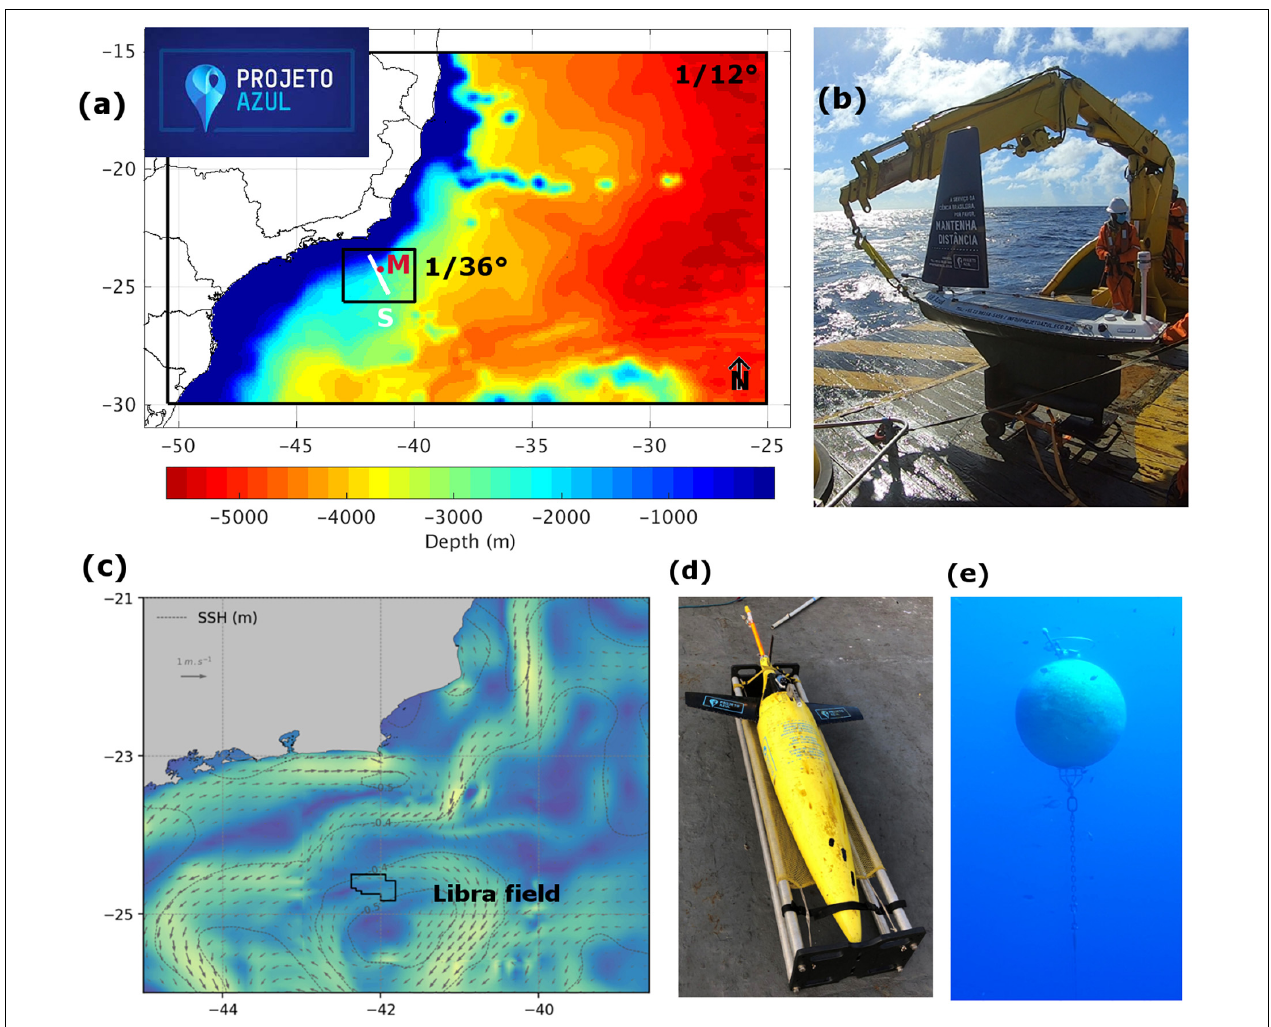
FIGURE 3 | (a) Representation of Project Azul’s nested grids (black rectangles) and their bathymetry (color shading), in meters, the approximated seaglider trajectories (S, white line) and the positioning of the instrumented mooring line and sail buoy deployment (M, red dot). (b) Sailbuoy deployment. (c) Surface current and sea surface height forecast for the study area and the location of Libra field. (d) Sea glider and (e) the instrumented moored line used in Project’s phase